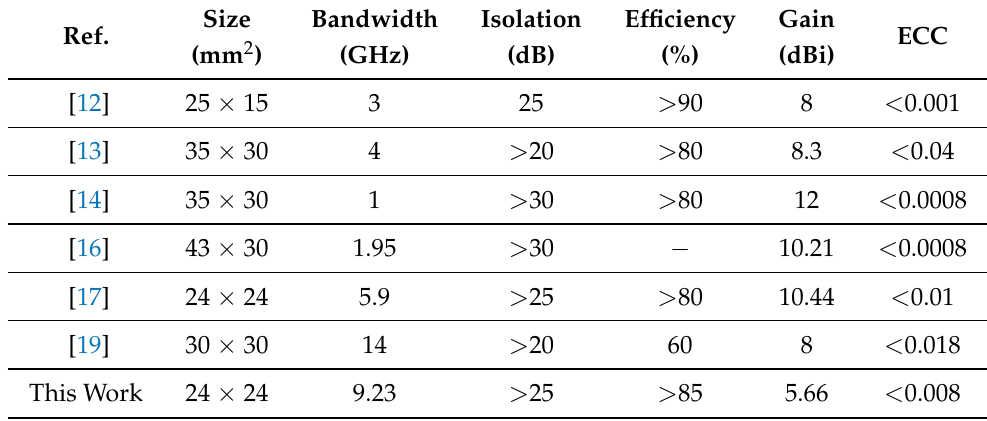
Table 2. Comparison among previously presented and proposed mmWave MIMO